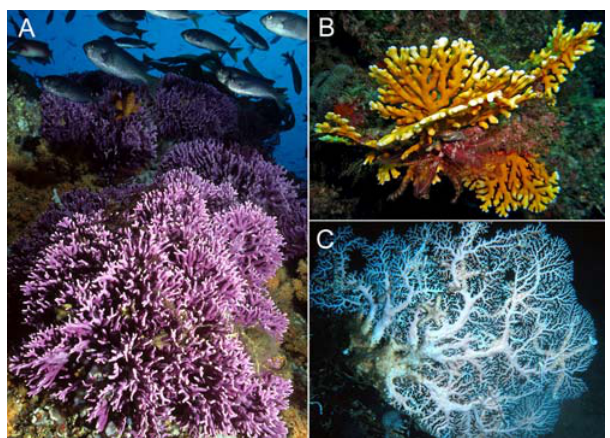
Figure 1. Stylasterid corals. (A) The shallow-water California hydrocoral Stylaster californicus , United States of America. (B) Tropical shallow-water species of Distichopora , Papua New Guinea. (C) Deep- water species of Stylaster , 536 meters depth, St. Lucia. Images courtesy of R Morse (A), M Baine (B), JK Reed (C).